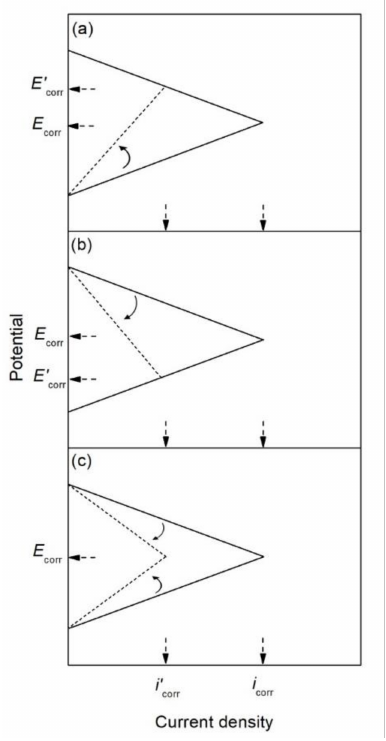
Figure 7. Evans diagrams showing the effect of a corrosion inhibitor, ( a ) on the anodic branch (anodic inhibitor), ( b ) on the cathodic branch (cathodic inhibitor), and ( c ) on both the anodic and cathodic branches (mixed inhibitor).